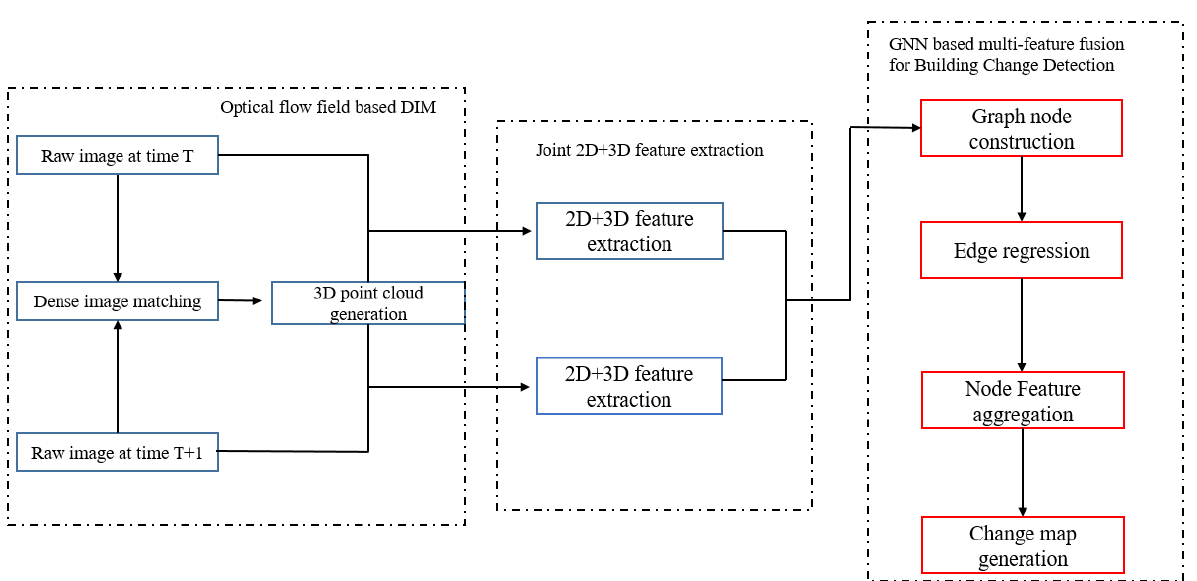
Figure 1. The workflow of the proposed GNN based multi-future fusion for building change